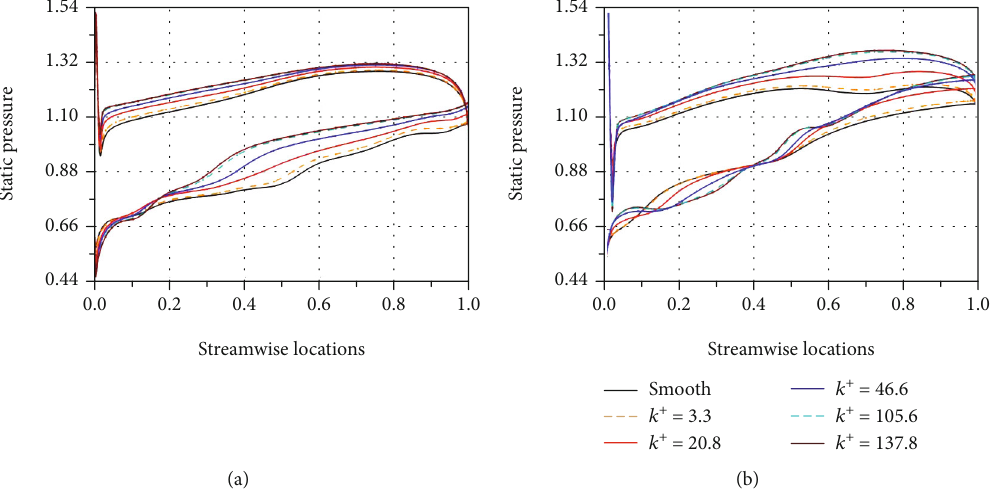
Figure 11: Blade loading distribution at 10% and 90% span heights.